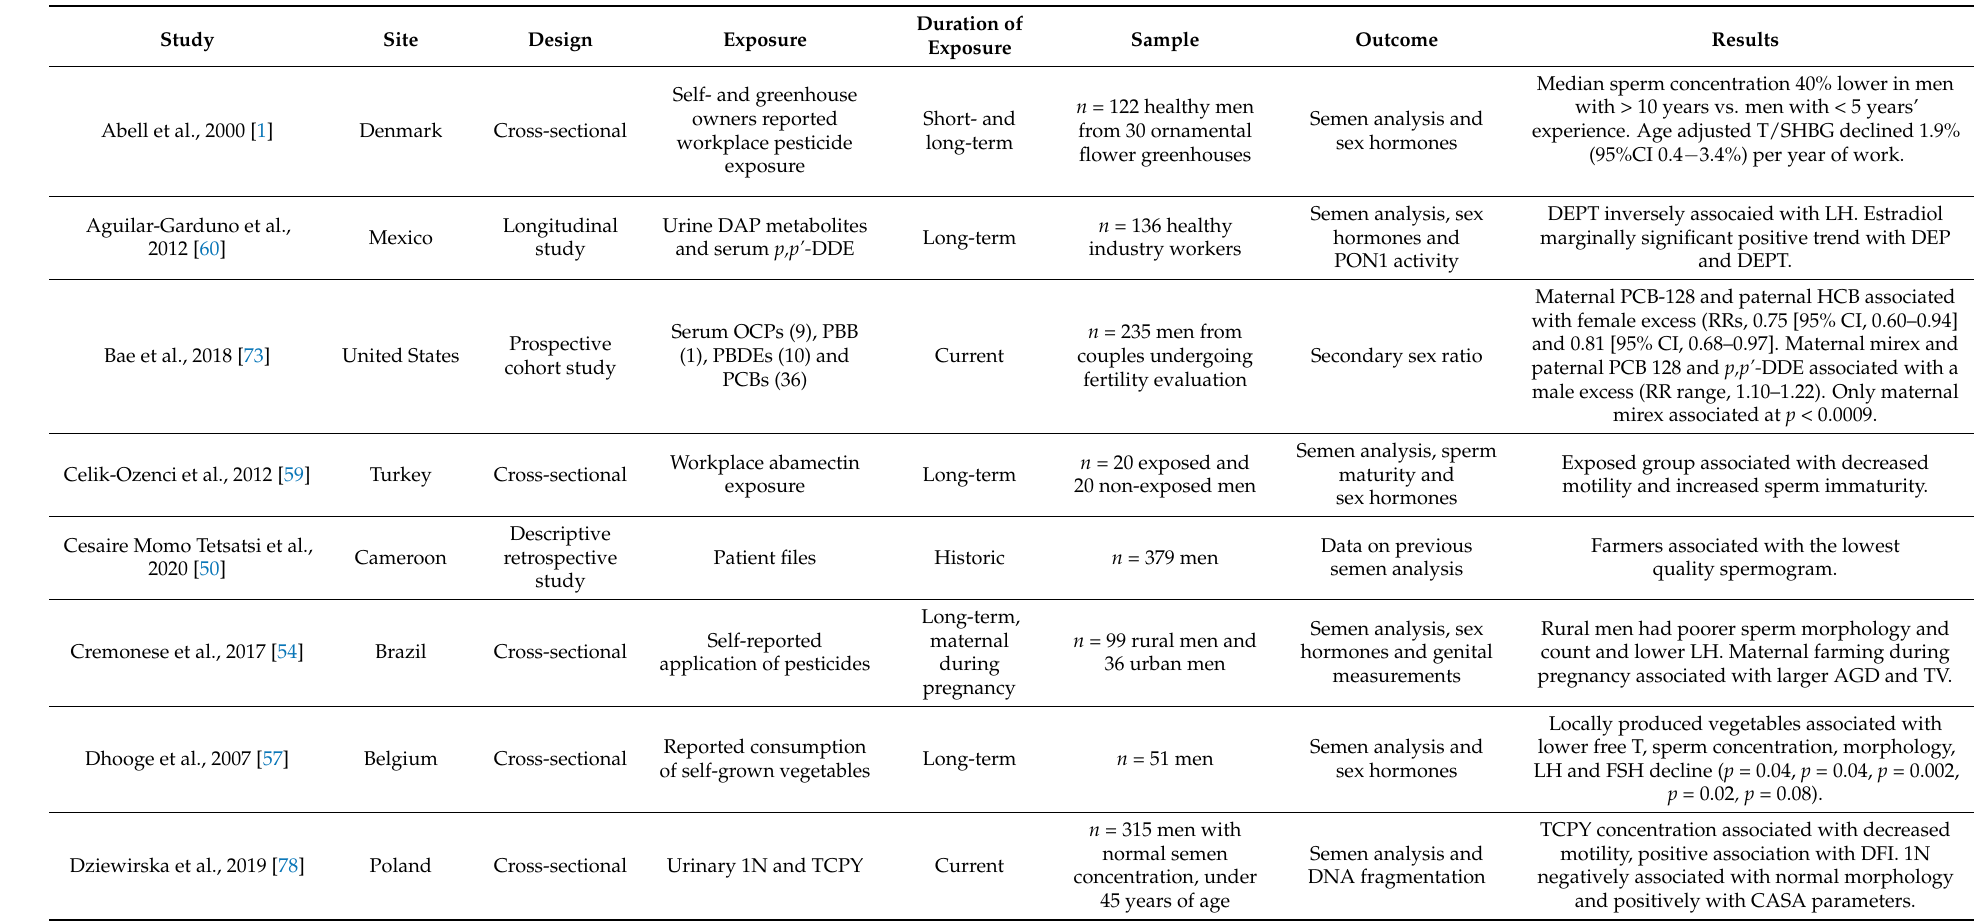
Table 2. Epidemiologic studies estimating association between pesticide exposure and male